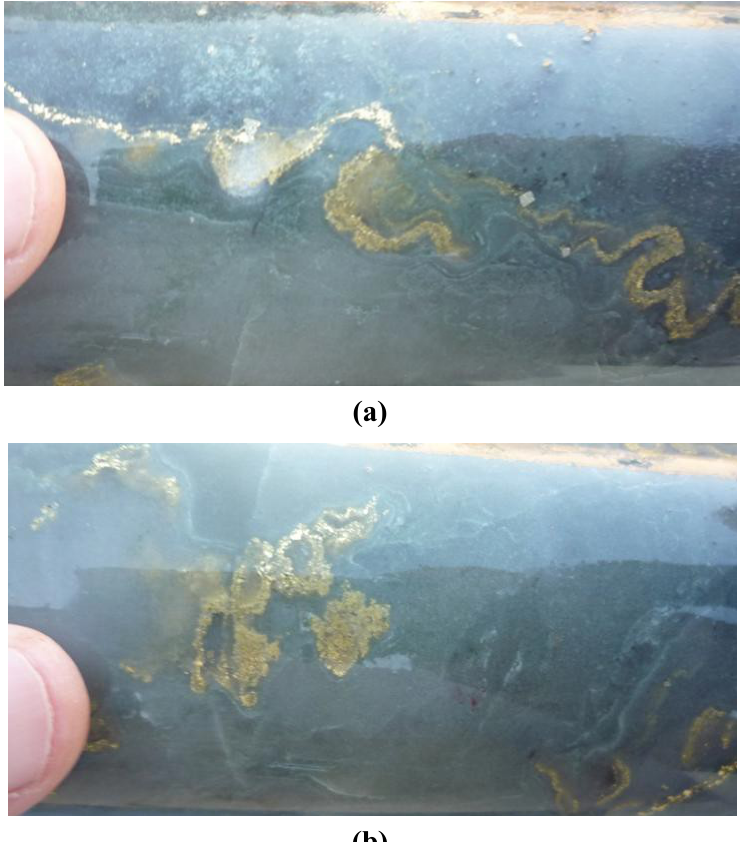
Figure 10. Photographs of diamond drill core from recent (2010) exploration drilling at the Haile deposit, South Carolina. Electrum bands (gold) are interpreted here to be formed similar to those from Sleeper and Buckskin National: by aggregation of electrum nanoparticles. Compare to Figure 2. Photographs are courtesy of Romarco